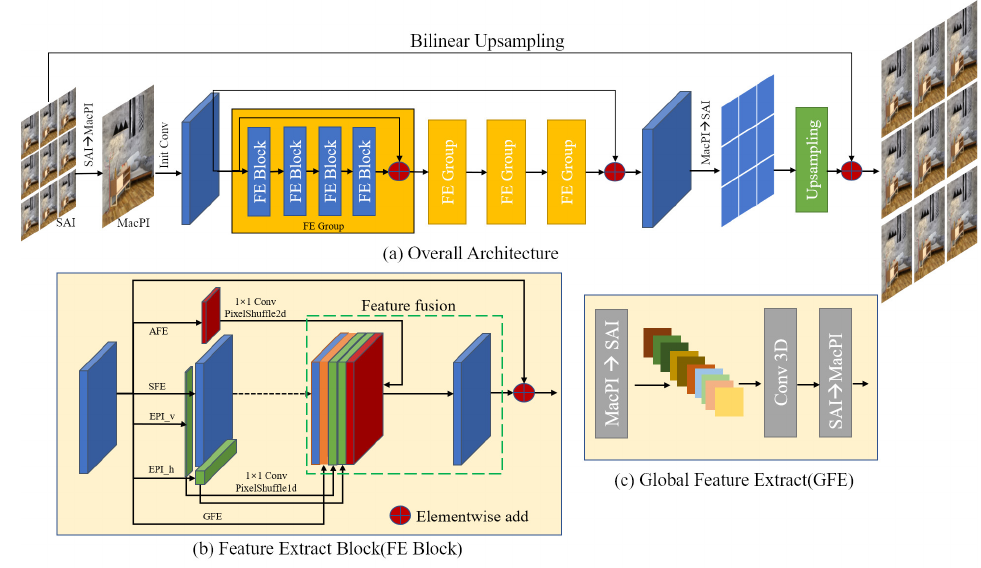
Figure 2. ( a ) The architectural overview of the MFSR. ( b ) Feature Extract Block(FEB). ( c ) Global Feature Extract Block(GFE). All up-sampling operator is the Bilinear